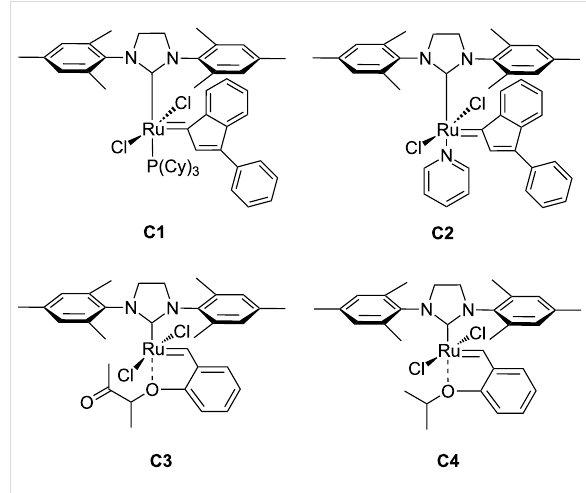
Figure 2: Ru–indenylidene metathesis catalysts C1 and C2 , “boomerang” complexes C3, and Hoveyda–Grubbs 2 nd generation catalyst C4 were studied for their efficiency and isomerization ten- dency in ADMET polymerizations.